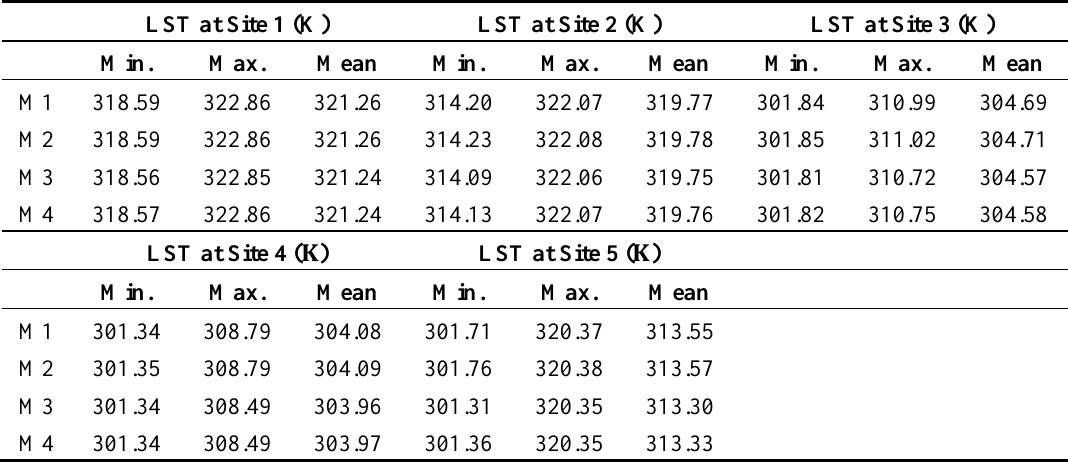
Table 3. Statistics of the distributed TASI LST (300 m) from four different upscaling methods in terms of the minimum, maximum and mean LST values at the five sites. Methods 1–4 are labeled as M1–M4, respectively. LST at Site 1 (K) LST at Site 2 (K) LST at Site 3